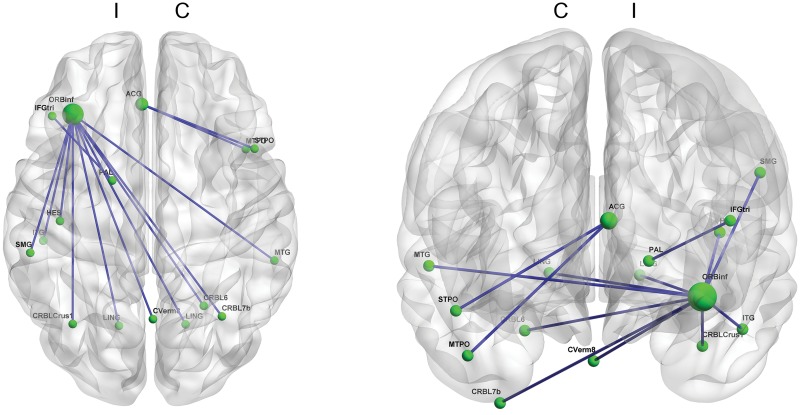
Functional connectivity correlated with the MDS-UPDRS part I score.The inferior orbito-frontal area in the ipsilateral hemisphere has substantial functional connectivity negatively correlated with the severity of non-motor symptoms. Other ipsilateral inferior frontal areas such as the pars triangularis and the anterior cingulate cortex also exhibit functional connectivity correlated with the severity of non-motor symptoms. (p<0.001) (Blue line: a functional connectivity negatively correlated with the MDS-UPDRS part I score; C: contralateral hemisphere & I: ipsilateral hemisphere; MDS-UPDRS: Movement Disorder Society-sponsored revision of the Unified Parkinson’s Disease Rating Scale)